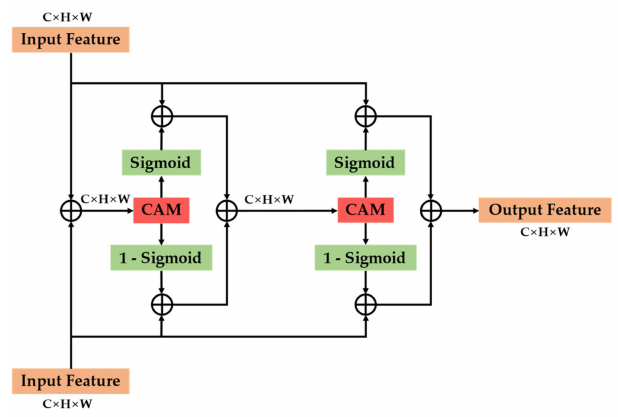
Figure 4. The proposed feature fusion